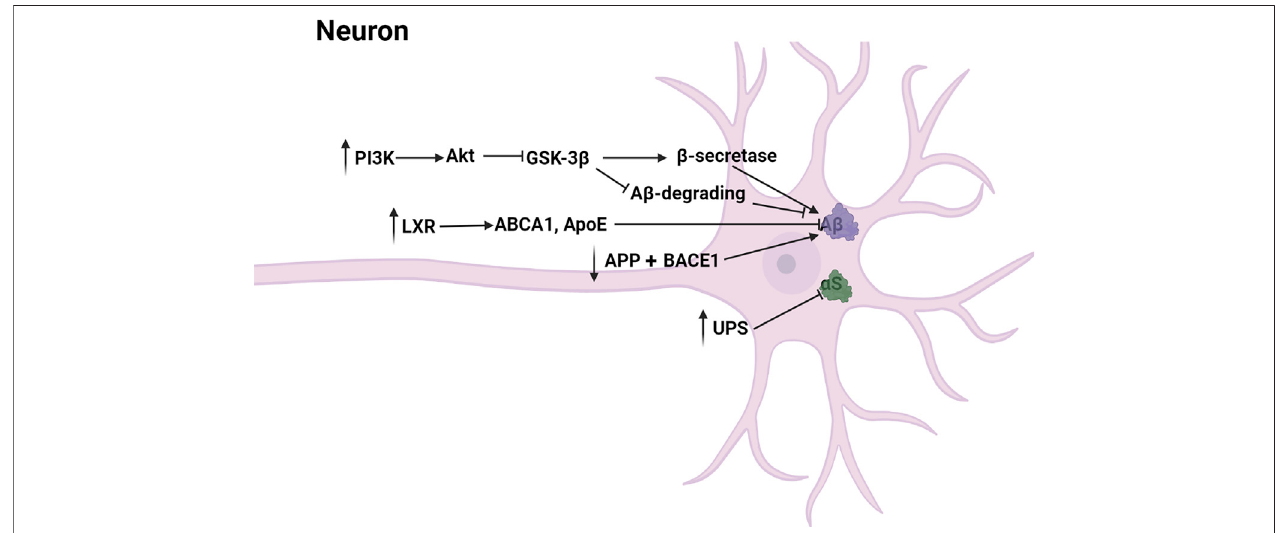
FIGURE 3 | Mechanisms involved in the reduction of neurotoxicity by